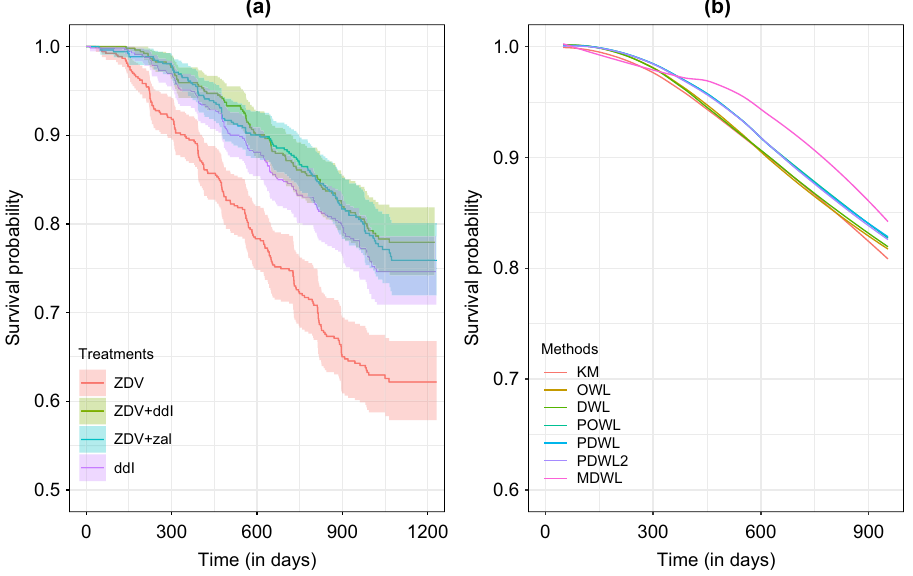
Figure 4. Nonparametric Kaplan–Meier curves of ACTG175 data under ( a ) given treatment arms and ( b ) optimal treatment